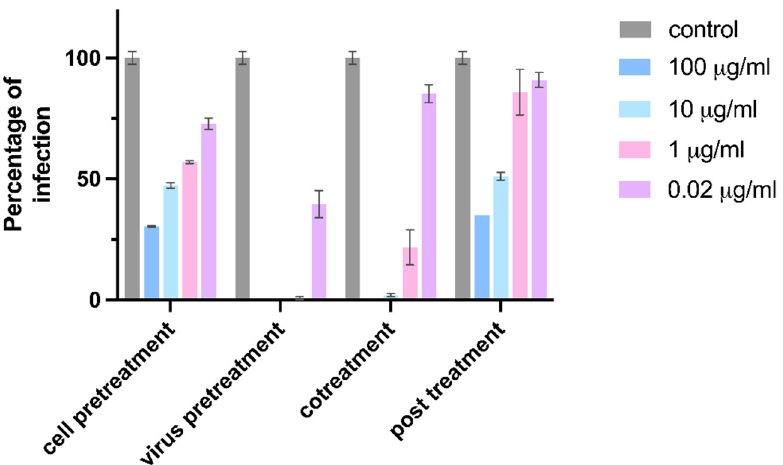
Figure 2. CD-6’SLN inhibition of H1N1 during various stages of viral infection. Cell pretreatment: compound was applied to the cells for 1 h, and the virus was added after washing the cell. Virus pretreatment: the virus was incubated with the compound for 1 h and added to the cells. Cotreatment: virus and compound were added simultaneously to the cells. Post-treatment: compound was added after viral attachment.